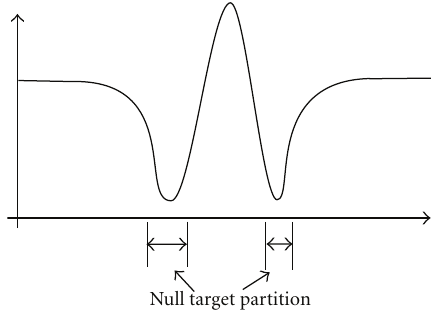
Figure 7: Visualization of a simple target density distribution with corresponding null target partition